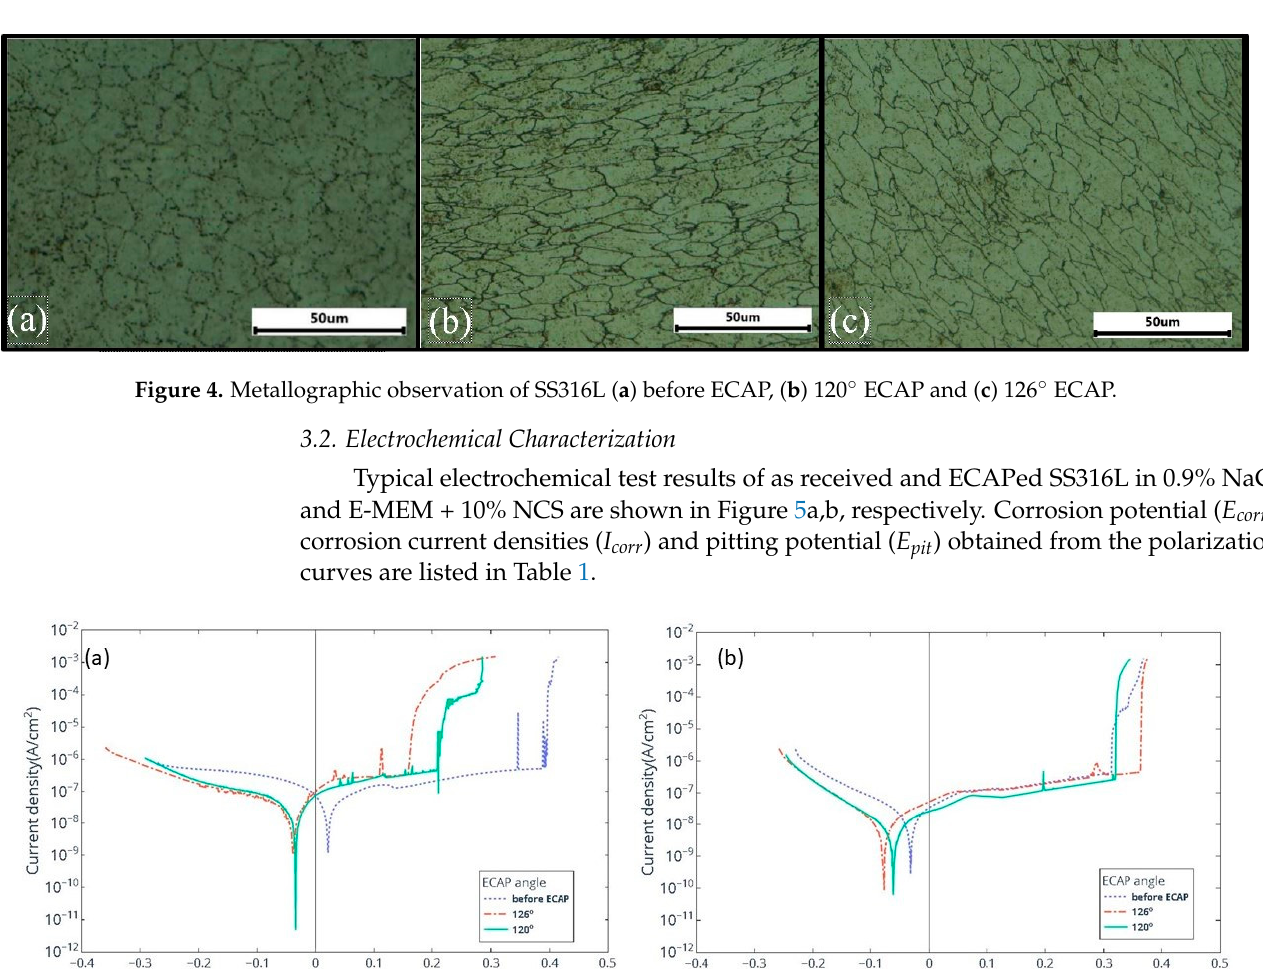
Figure 3. Hardness profile of SS316L samples.